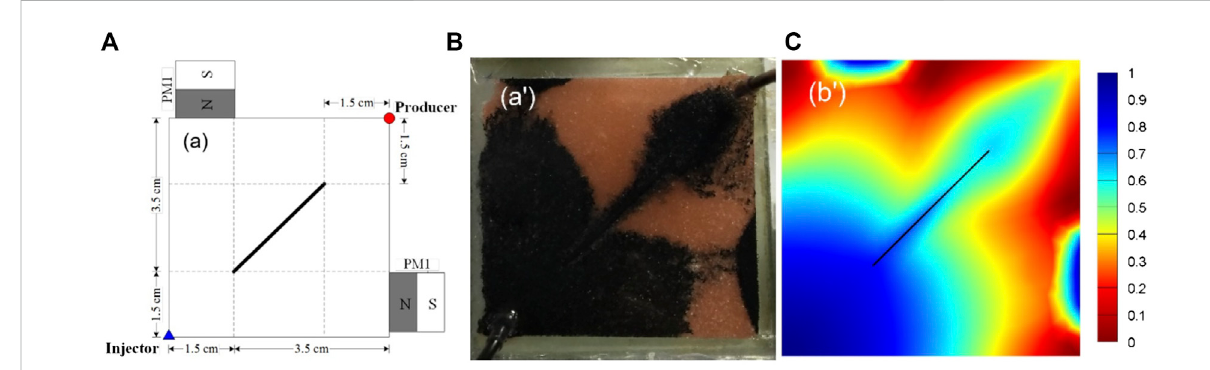
FIGURE 17 (A) Schematic of sand pack with injector, producer, and permanent magnets. (B) Photo of sand pack with ferro fl uid (dark color). (C) Simulated ferro fl uid saturation in the sand pack (Huang et al.,